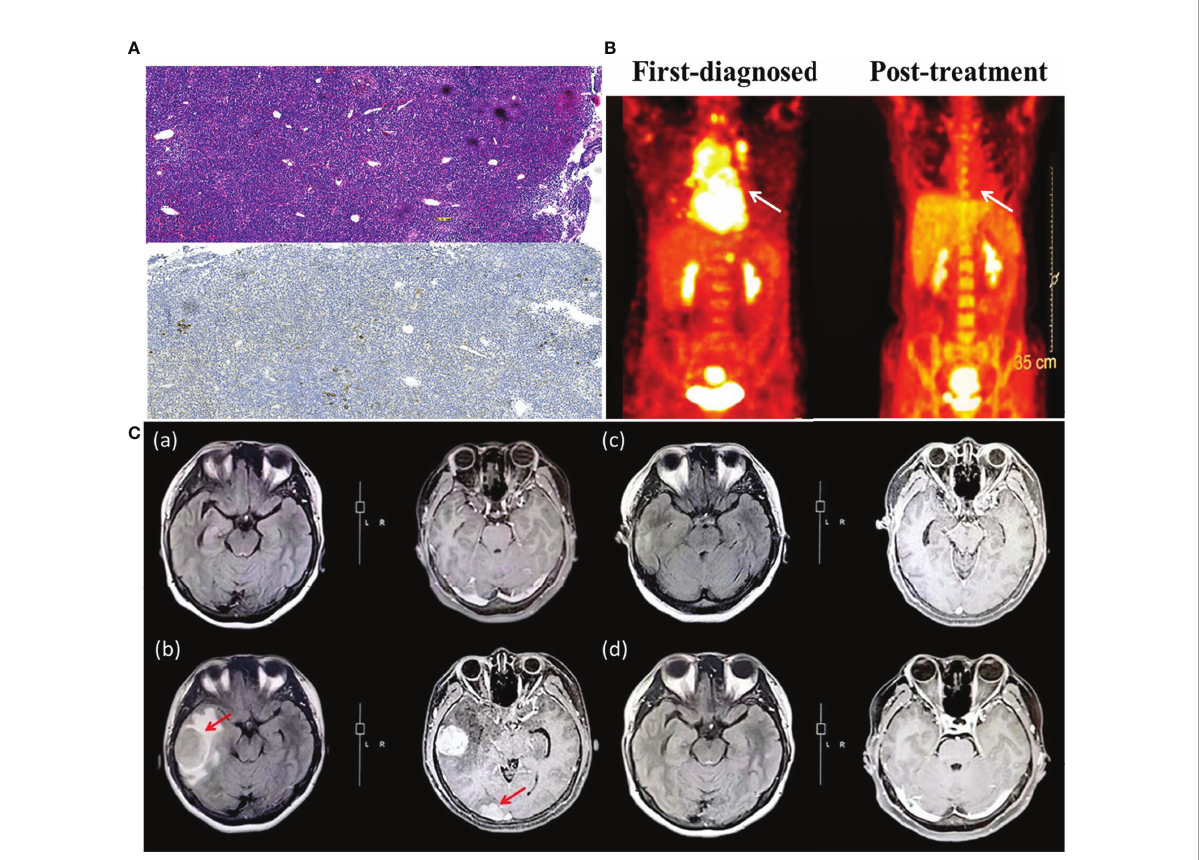
FIGURE 2 (A) The pathological section of mediastinum lymphatic tissue (upper panel: hematoxylin and eosin stain; lower panel: immunohistochemistry, CD30 negative). (B) Positron emission tomography assessment of patient fi rst diagnosed (left) and after CAR-T cells infusion (right). The white arrow indicates the invasion of DLBCL on the mediastinum, which is the primary site. (C) Brain MRI images before and after CAR-T cell therapy. (a) Brain MRI on March 2020, after the second cycle of chemotherapy of R2-ICE*5 and evaluated as CR2. (b) Brain MRI on May 2020, when the patient showed CNS relapse. The size of the right temporal lobe and occipital lobe masses are 3.19 cm×4.03 cm and1.75 cm×2.4 cm, respectively. (c) The same region on October 2020, more than 4 months after CAR-T cells infusion. The mass almost disappeared and was evaluated as CR for 2 months. (d) The follow-up image on December 2020 with continuous